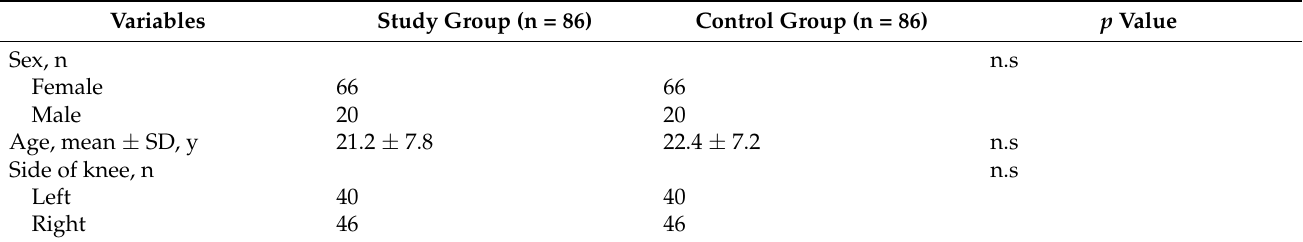
Table 1. Demographic characteristics of the participants.